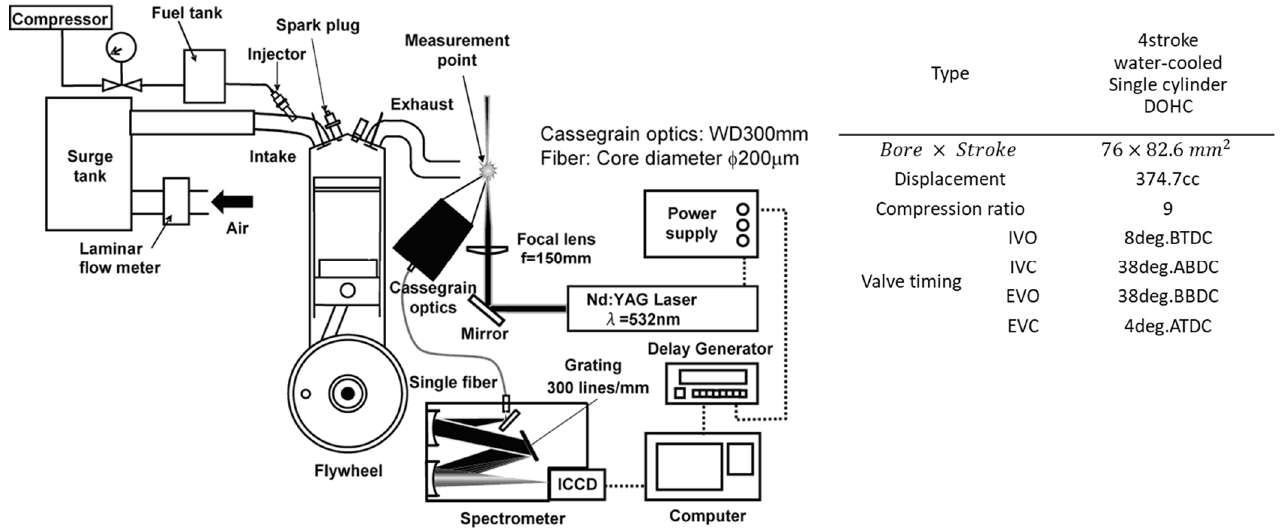
Figure 1. The experimental setup for the exhaust gas measurement by LIBS and engine